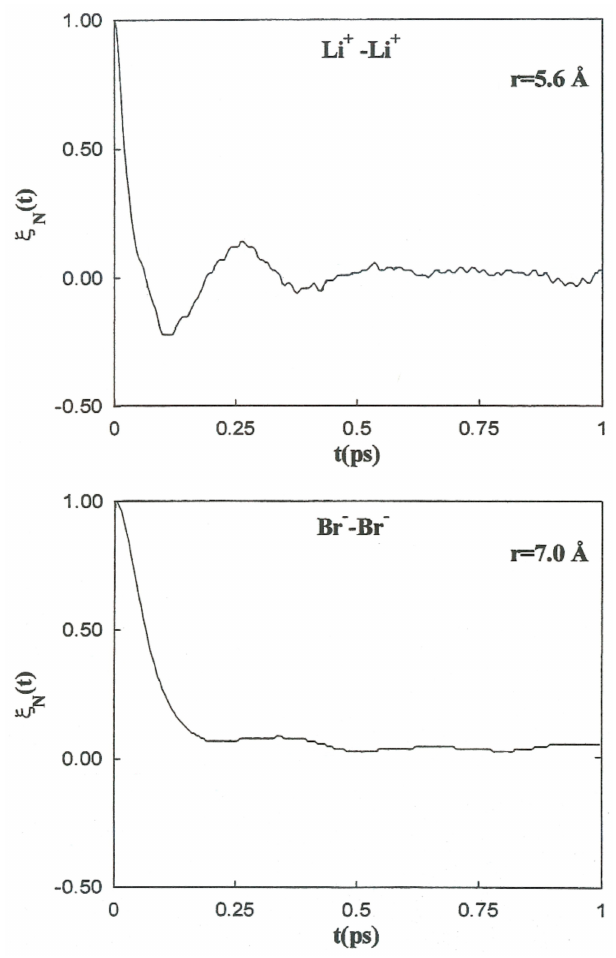
Figure 11. Normalized friction kernels for the Li + -Li + ion pair (top) and Br − -Br − ion pair (bottom) at various interionic